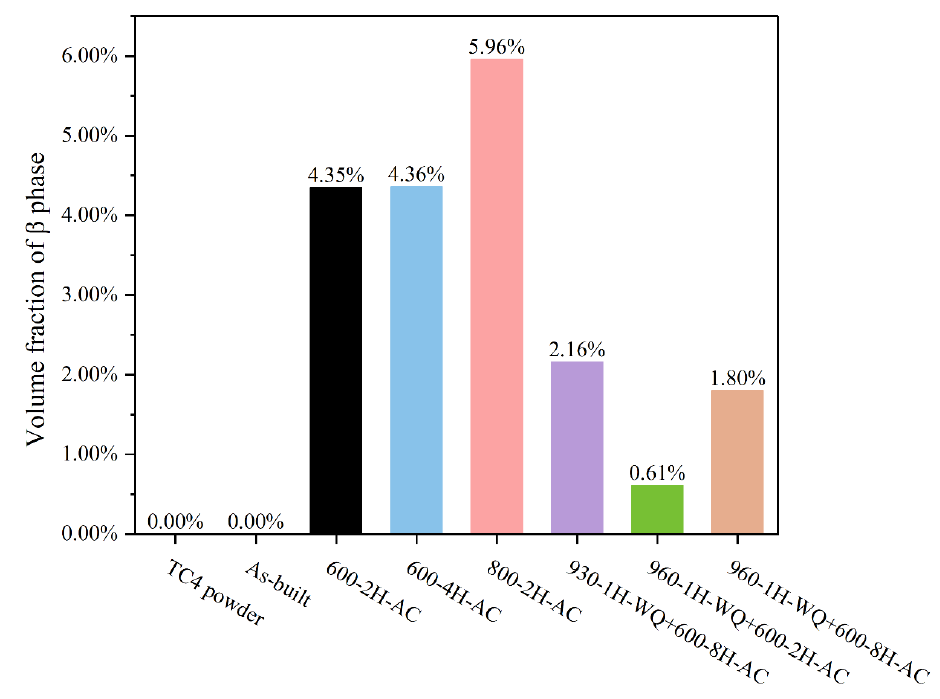
Figure 8. Volume fraction of β phase in SLM TC4 under different heat treatments.